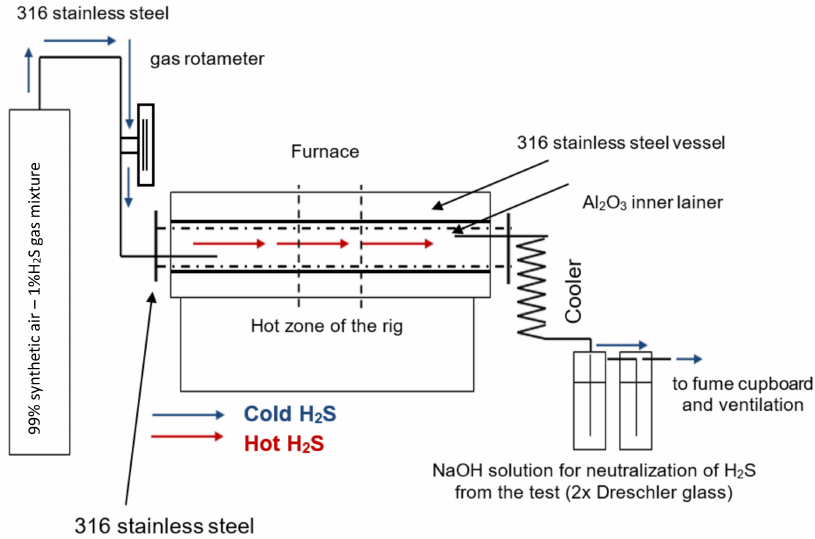
Figure 1. Schematic of the experimental rig for high-temperature sulfidation-oxidation. Similar to our previous work, the samples placed onto the high-alumina refractory holder maintaining adequate gas flow circulation were inserted into the furnace chamber. The samples were heated to 500 ◦ C with a ramp rate 5 ◦ C/min and then held at this temperature for a certain time. The testing comprised 3 cycles of 168 h (1 week) per cycle. After each cycle, the samples were examined according to the previous study